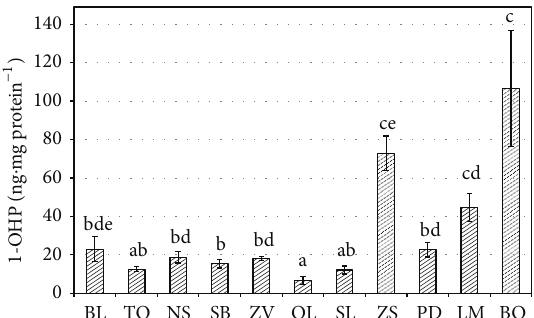
Figure 2: Content (mean ± standard error of mean) of 1-OHP in bile samples from fish at monitored sites (BL: Berounka site/Luˇznice River; TO: Topˇelec site/Otava River; NS: Nespeky site/S´azava River; SB: Srbsko site/Berounka River; ZV: Zelˇc´ın site/Vltava River; OL: Obˇr´ıstv´ı site/Labe River; SL: Schmilka site/Labe River; ZS: ˇZidlochovice site/Svratka River; PD: Pohansko site/Dyje River; LM: Lanˇzhot site/Morava River; BO: Bohum´ın site/Odra River). Significant differences ( 𝑃 < 0.05 ) are indicated by different alphabetic